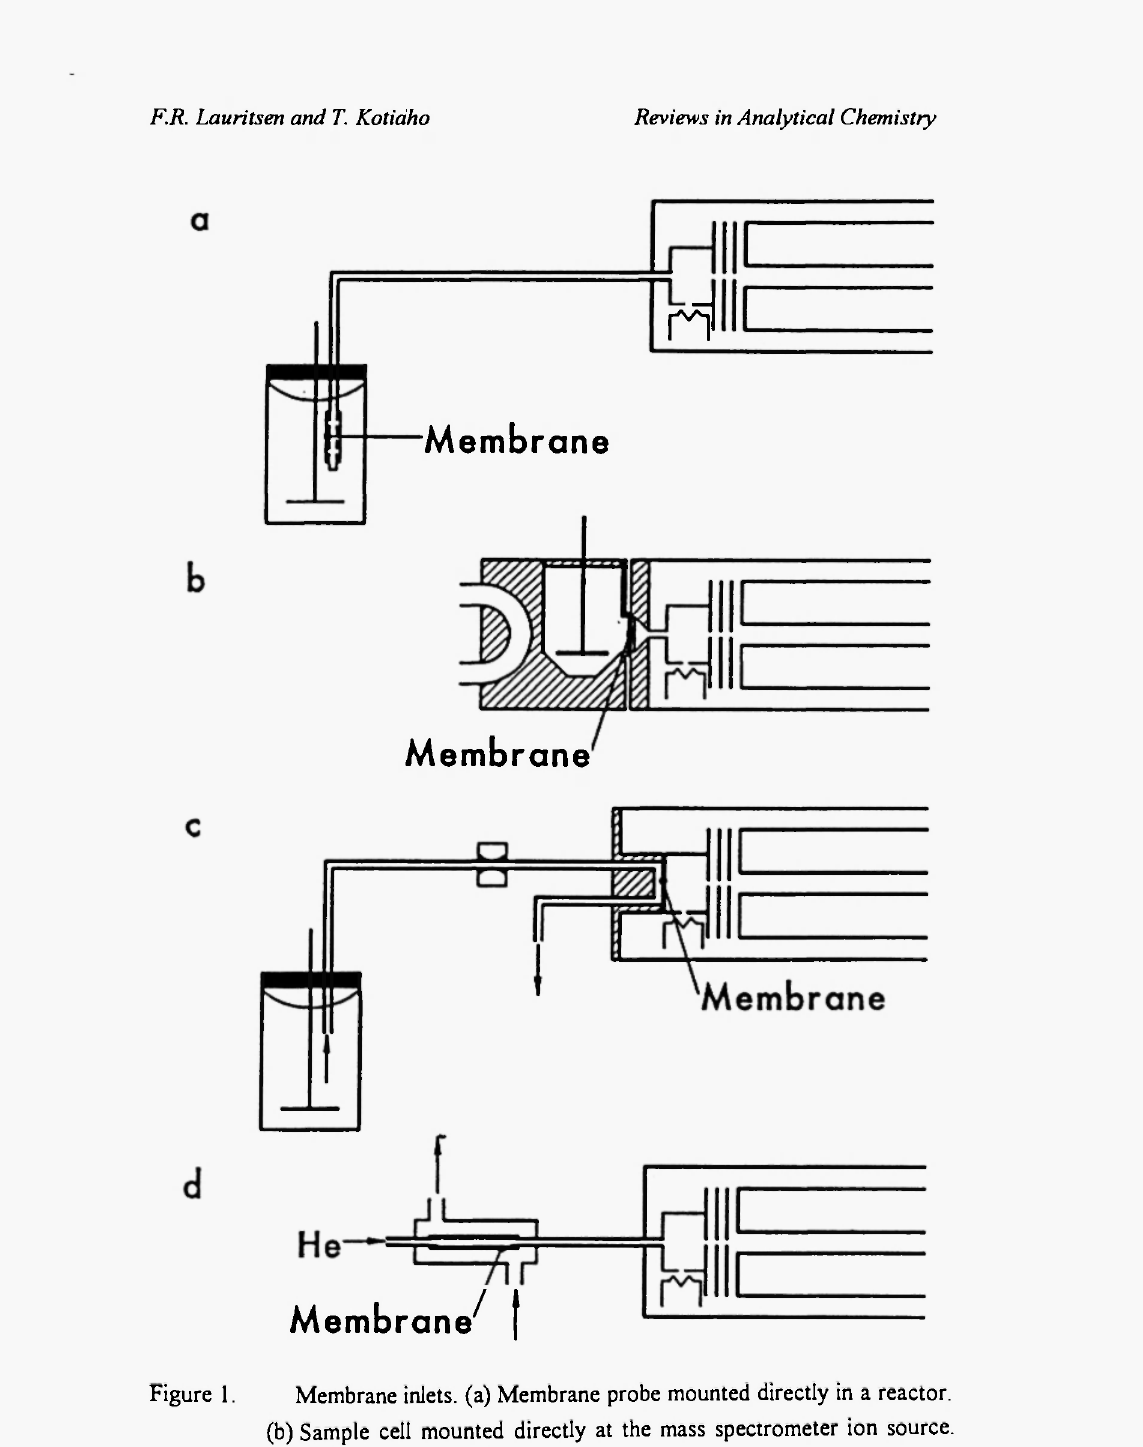
Figure 1. Membrane inJets, (a) Membrane probe mounted directly in a reactor. (b) Sample cell mounted directly at the mass spectrometer ion source. (c) Flow-through membrane probe, (d) Helium purge membrane inlet Adapted from reference [4],